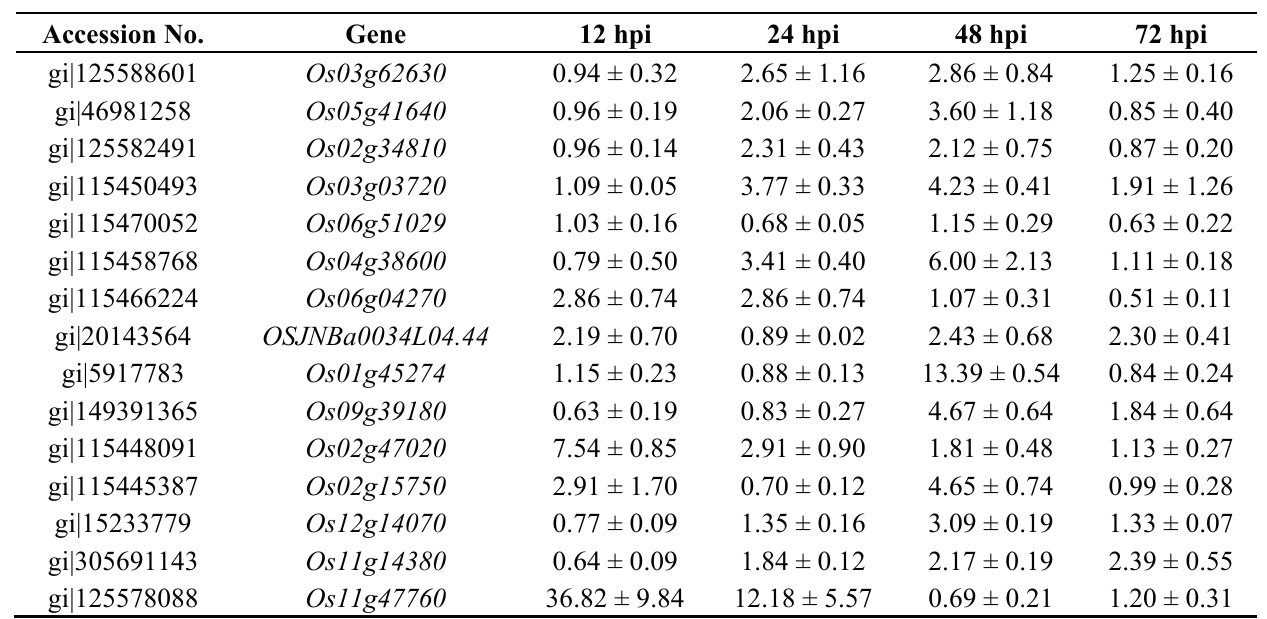
Table 3. Transcriptional changes of differentially expressed proteins induced by Pst relative to the mock